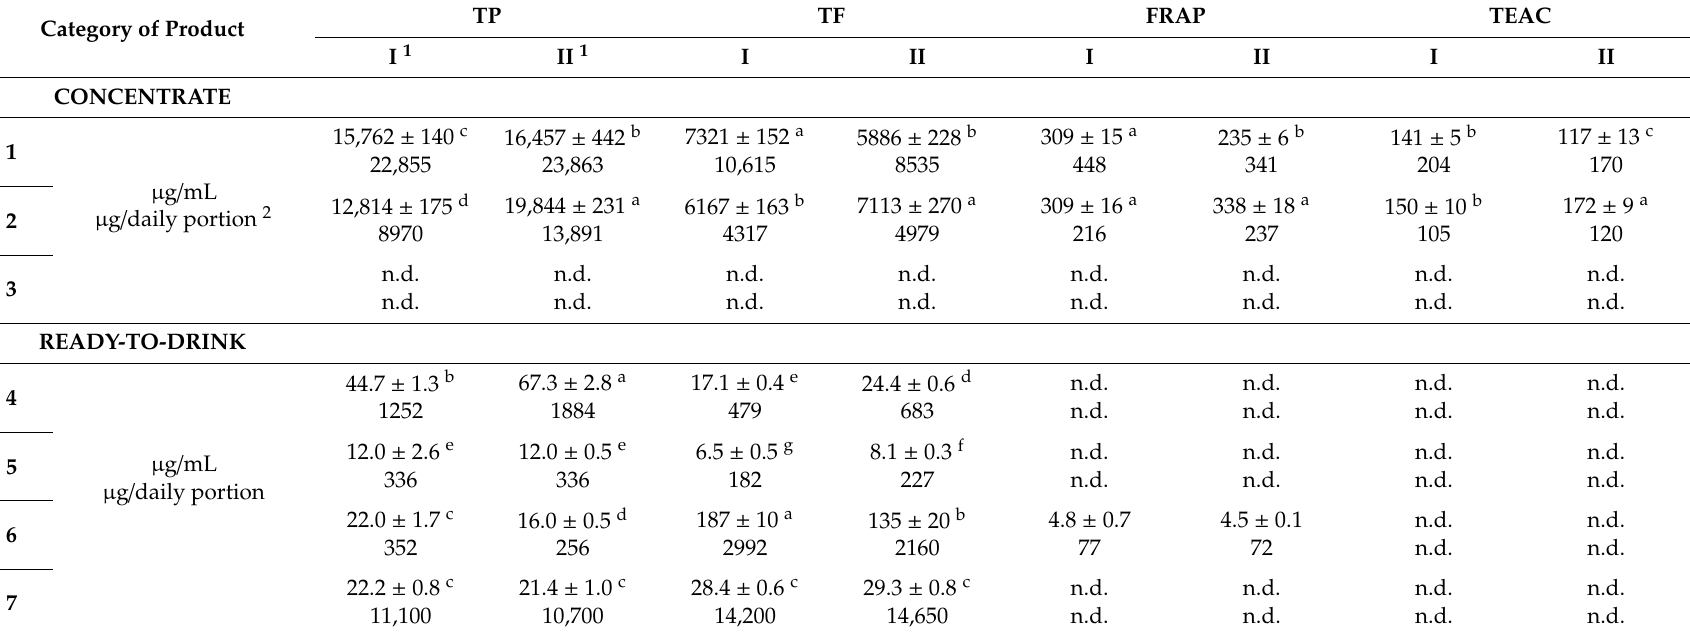
Table 3. The antioxidant capacities expressed as the total polyphenol (TP) and total flavonoid (TF) ( µ g / mL), ferric reducing ability of plasma (FRAP) and trolox equivalent antioxidant capacity (TEAC) ( µ mol / mL) of fulvic acid